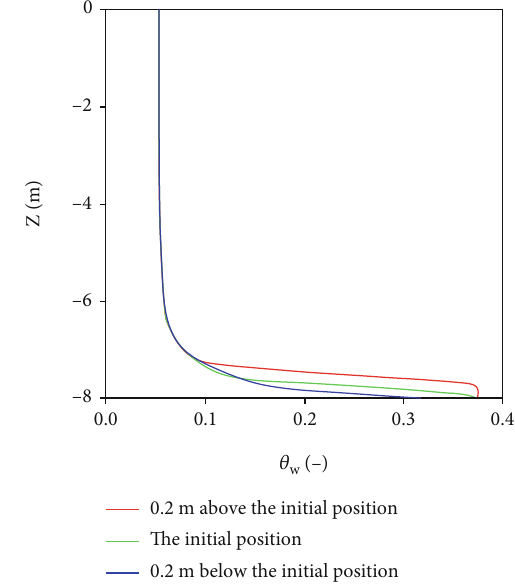
Figure 4: Transient vertical distributions of normalized gaseous TCE concentration at x = 10 m .